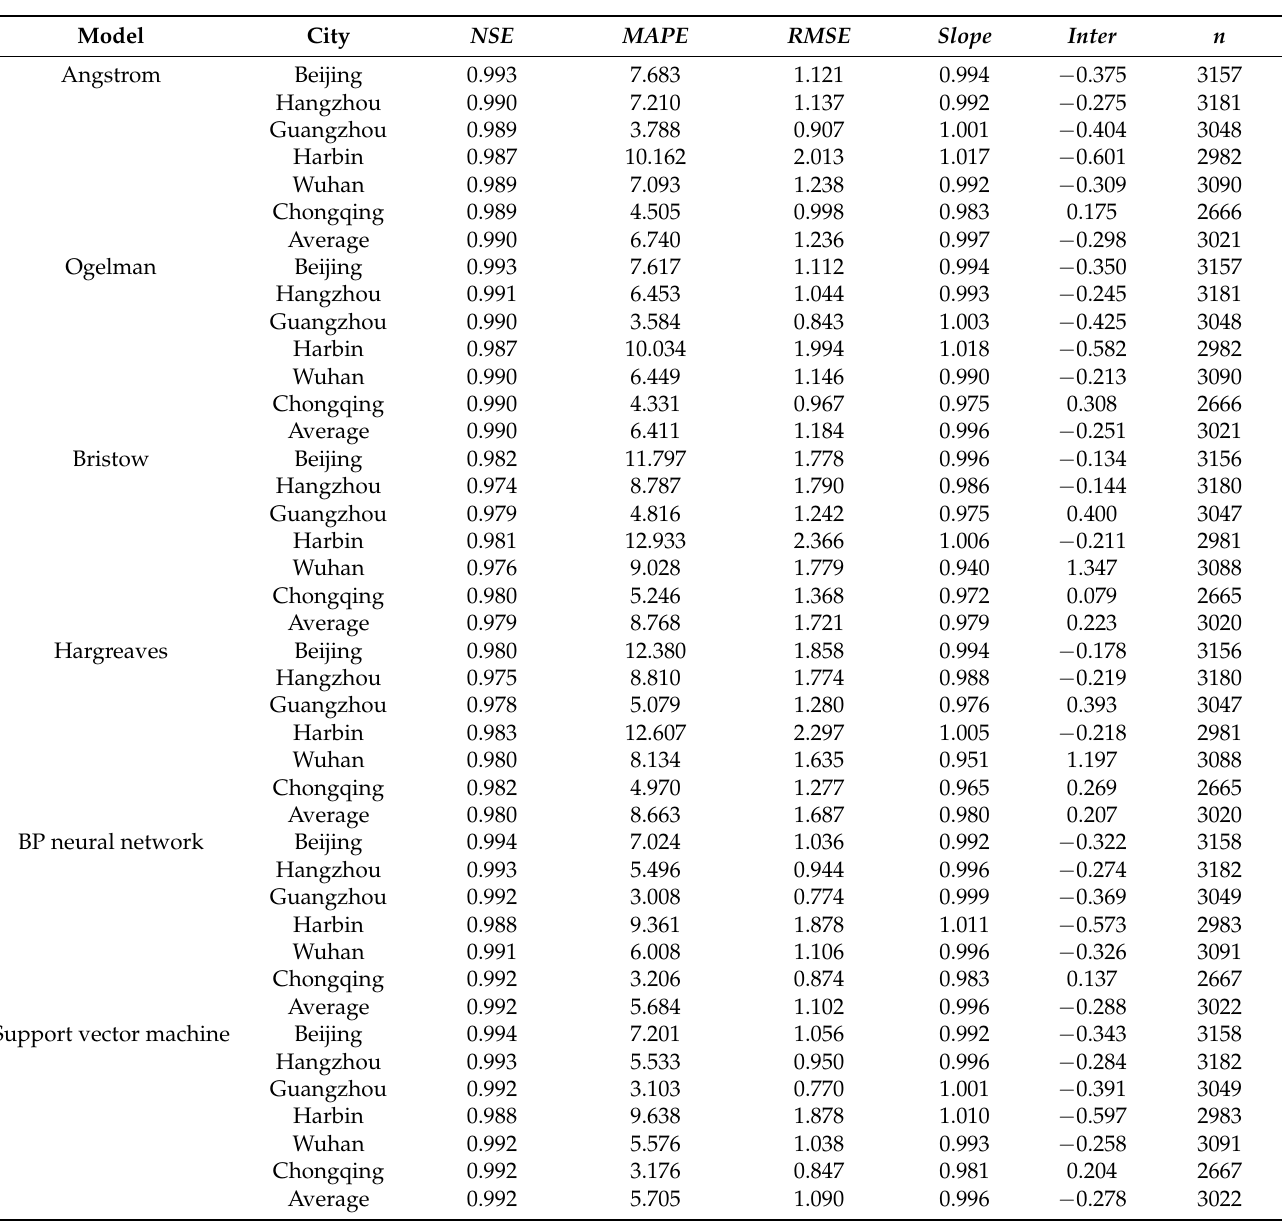
Table 5. Validation results of the UTCI calculation based on solar radiation estimated by empirical models and machine-learning